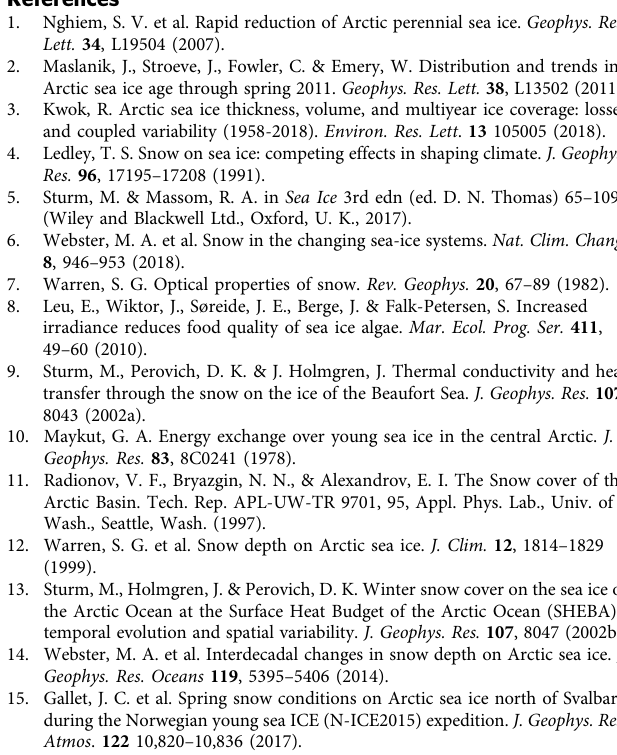
Supplementary Table 4. IMBs are equipped with a sonic range- fi nder which detects the snow (or ice) surface at four-hourly intervals. Given instrumental uncertainty and precision, we de fi ned accumulation events as an increase in snow depth greater than one centimeter within a 24-hour window 23 . The data were quality checked for erroneous values due to changes in buoy orientation, the formation or removal of large snow drifts, and false GPS readings. While this check improves the data quality, some detected changes in surface elevations may be due to wind-driven redistribution of snow. The reader is referred to ref. 55 . for additional details on the quality